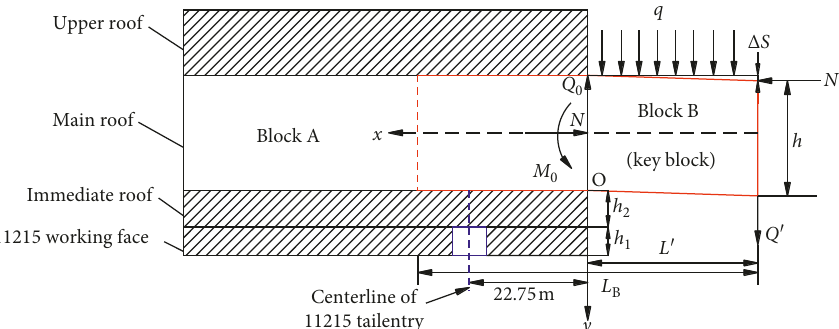
Figure 11: Mechanical model of the cantilever